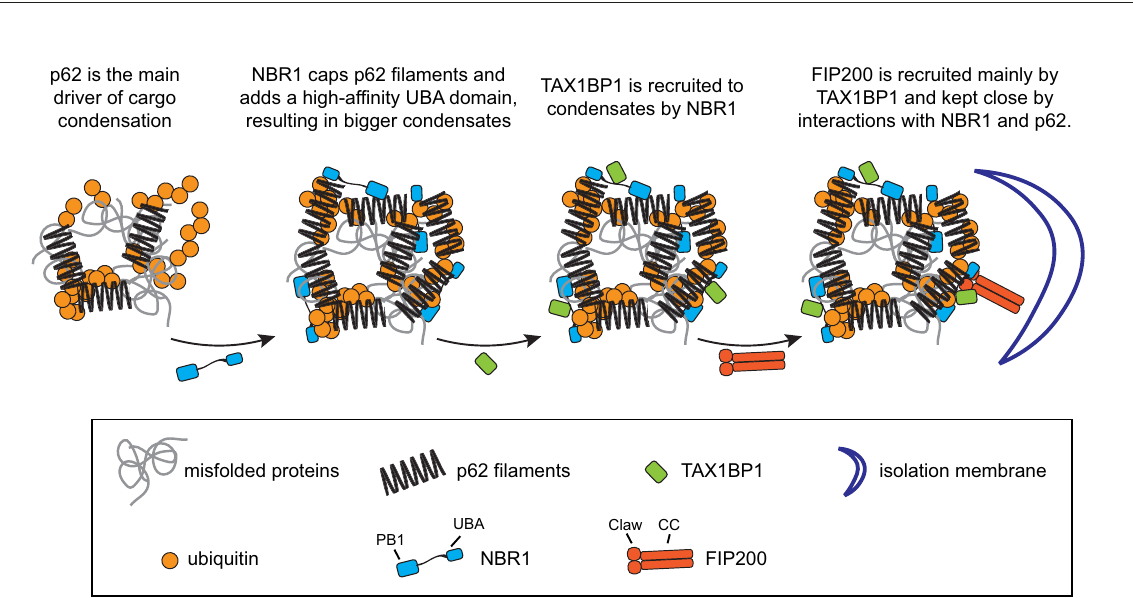
Fig. 7 Model of cargo receptors ’ interplay in autophagy initiation. The model illustrates how each cargo receptor contributes to ubiquitin condensate formation and to the recruitment of the autophagy machinery to initiate